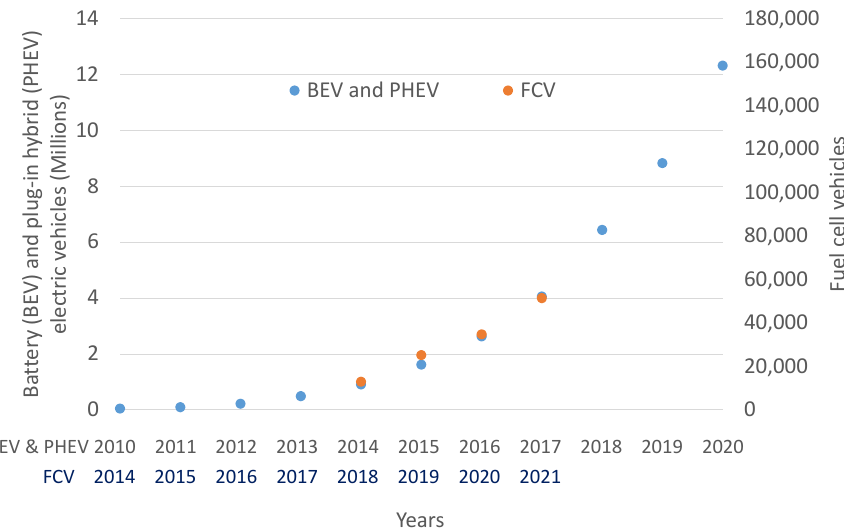
Figure 19. Comparison of the deployment trends of BEVs and PHEVs 2010–2020 (source: IEA [5]), left; and all FCVs 2018–2021 (source: [6,23–25] and this work), right.